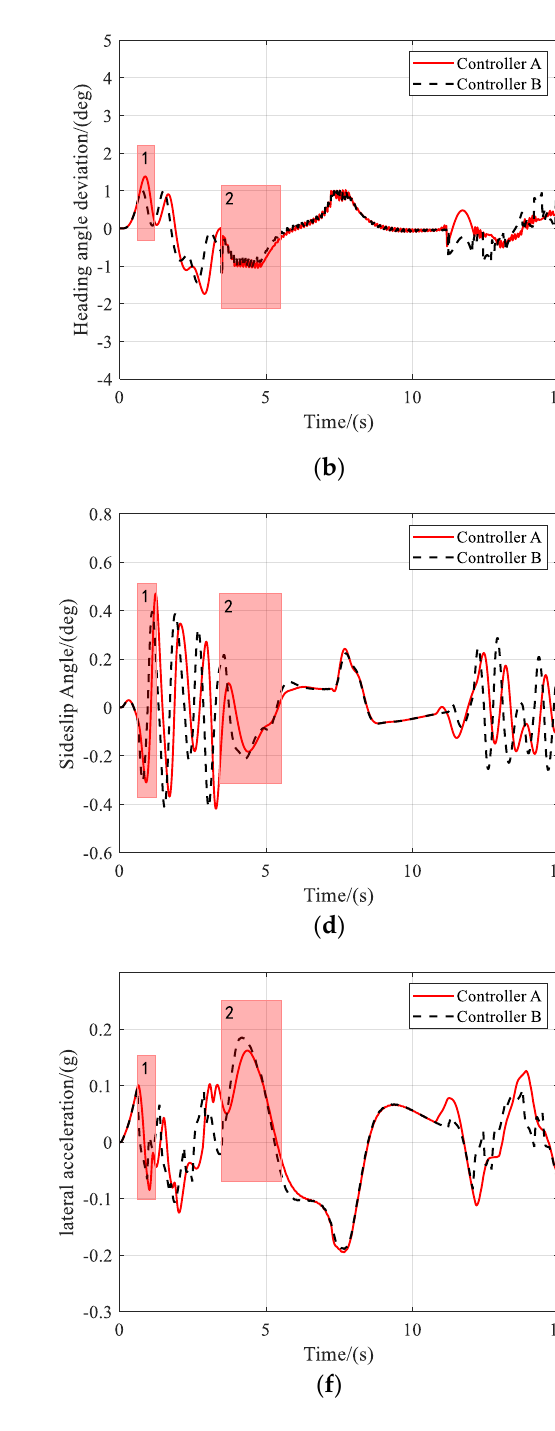
Figure 9. Scenario 2: Simulation results at 72 km/h. ( a ) Vehicle trajectory, ( b ) heading angle deviation, ( c ) the front wheel angle, ( d ) sideslip angle, ( e ) weight factor, and ( f ) lateral acceleration.